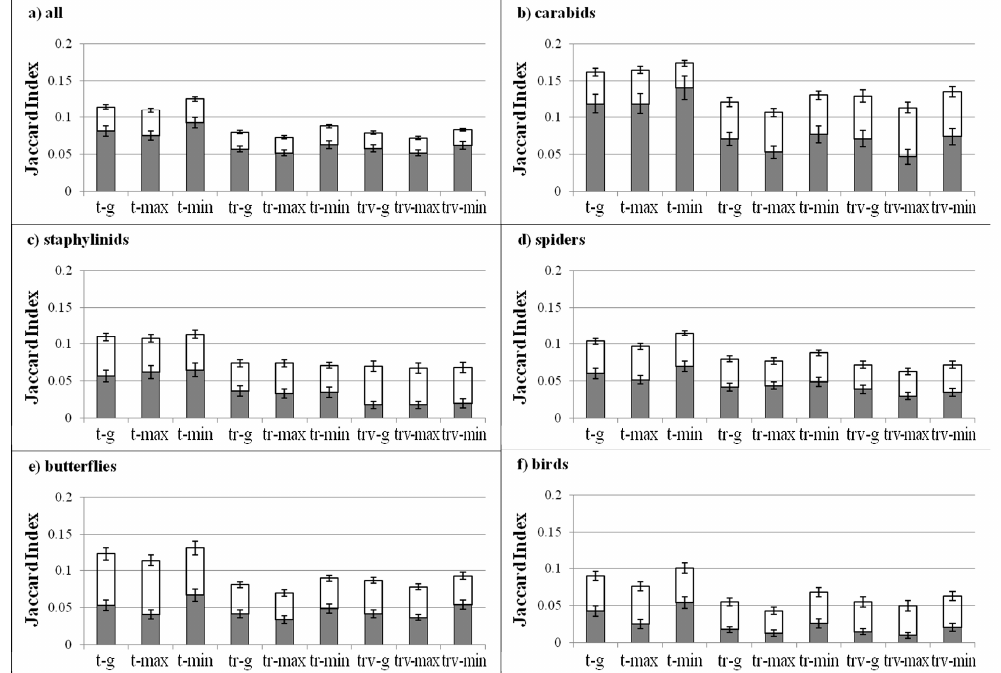
Figure 6. Temporal dissimilarity. The panels show the two components of the Jaccard index, namely turnover ( β sim in grey) and nestedness ( β sne in white), for all taxa pooled together ( a ) and for each taxon separately ( b – f ). Bar charts indicate mean values and error bars are the standard error across model classes and scenarios.